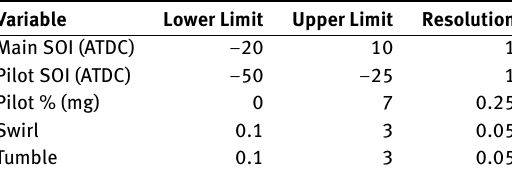
Table 2: Range and resolution of design variables for single